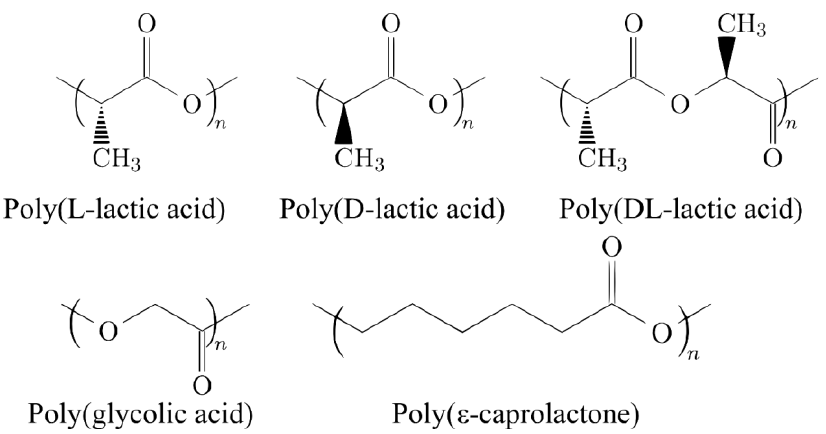
Figure 1. Chemical structure of the different poly(α -hydroxy ester).